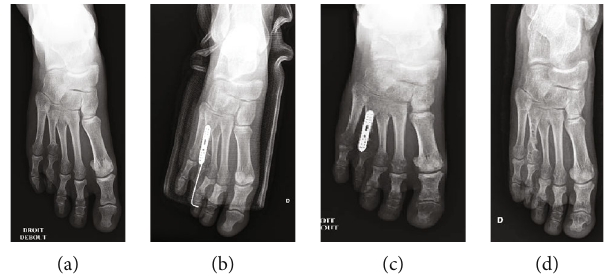
Figure 2: Case 1, a 20 years old female with a brachymetatarsia of the right fourth toe. (a) Preoperative X-ray of the right foot showing the shortness of around 10 mm. (b) Postoperative X-ray of the right foot. (c) Postoperative X-ray after K-wire removal at 1-month follow-up. (d) Postoperative X-ray after plate removal at 1-year